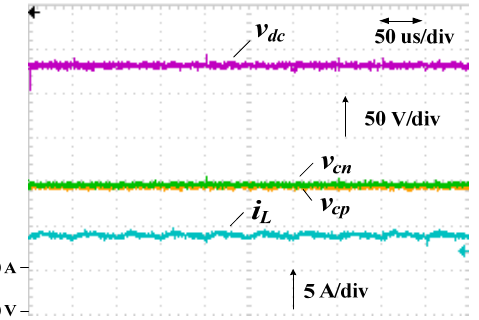
Figure 11. Steady state characteristics of series